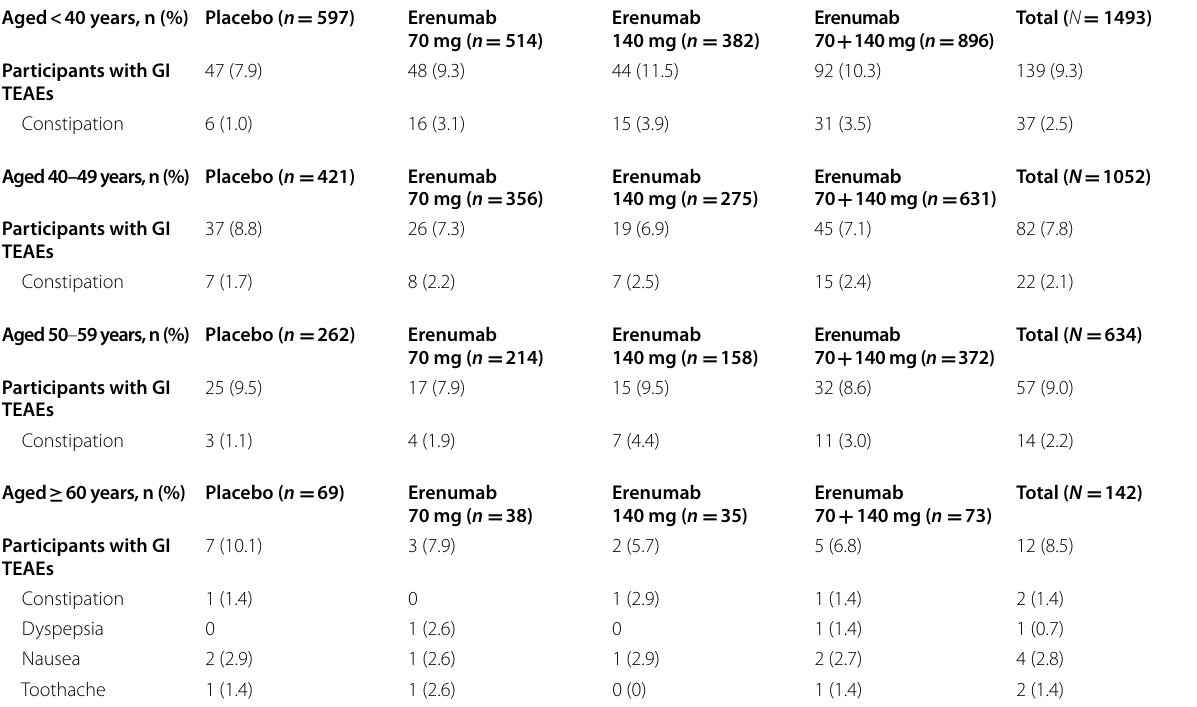
Data pooled from phase 2 CM, STRIVE, ARISE, LIBERTY, and EMPOwER studies (safety analysis set). The table contains AEs with onset date within 91 days from the first administration of the study drug. AEs are presented at the dose level at which the event occurred, so individuals who received erenumab at more than 1 dose level during the study were counted in both dose levels. Therefore, the total erenumab column may not be the sum of the individuals included in each of the individual dose levels. % n/N 100 = × Abbreviations: AE Adverse event, CM Chronic migraine, GI Gastrointestinal, N Number of individuals exposed to the given dose level, n number of individuals reporting at least 1 occurrence of an AE in that class within 91 days from the first administration, TEAE Treatment-emergent adverse event